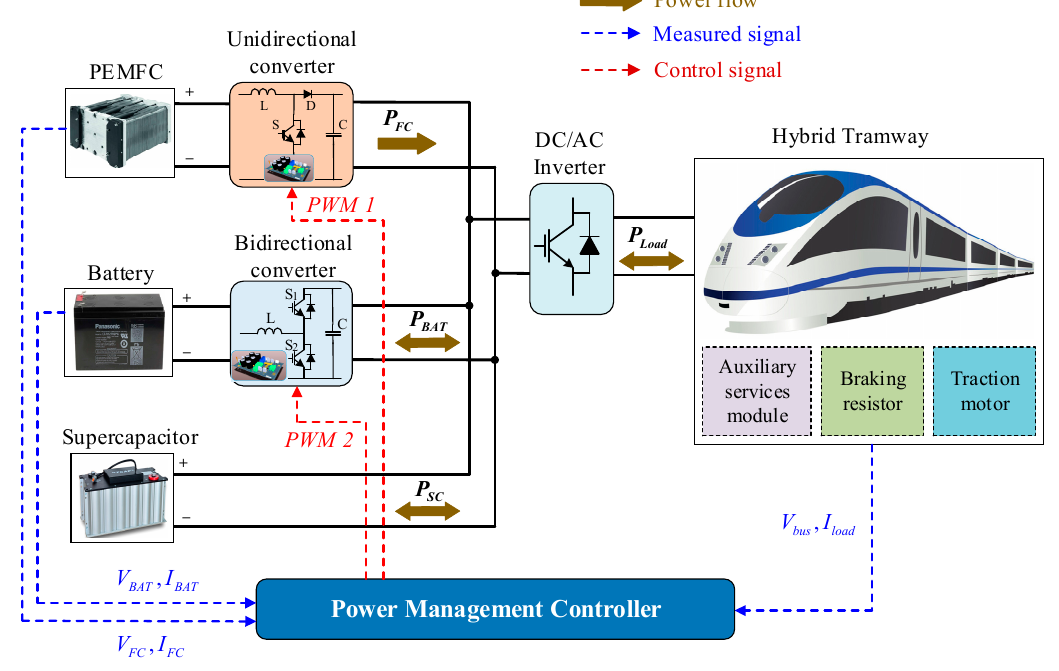
Figure 1. Configuration of hybrid tramway system.